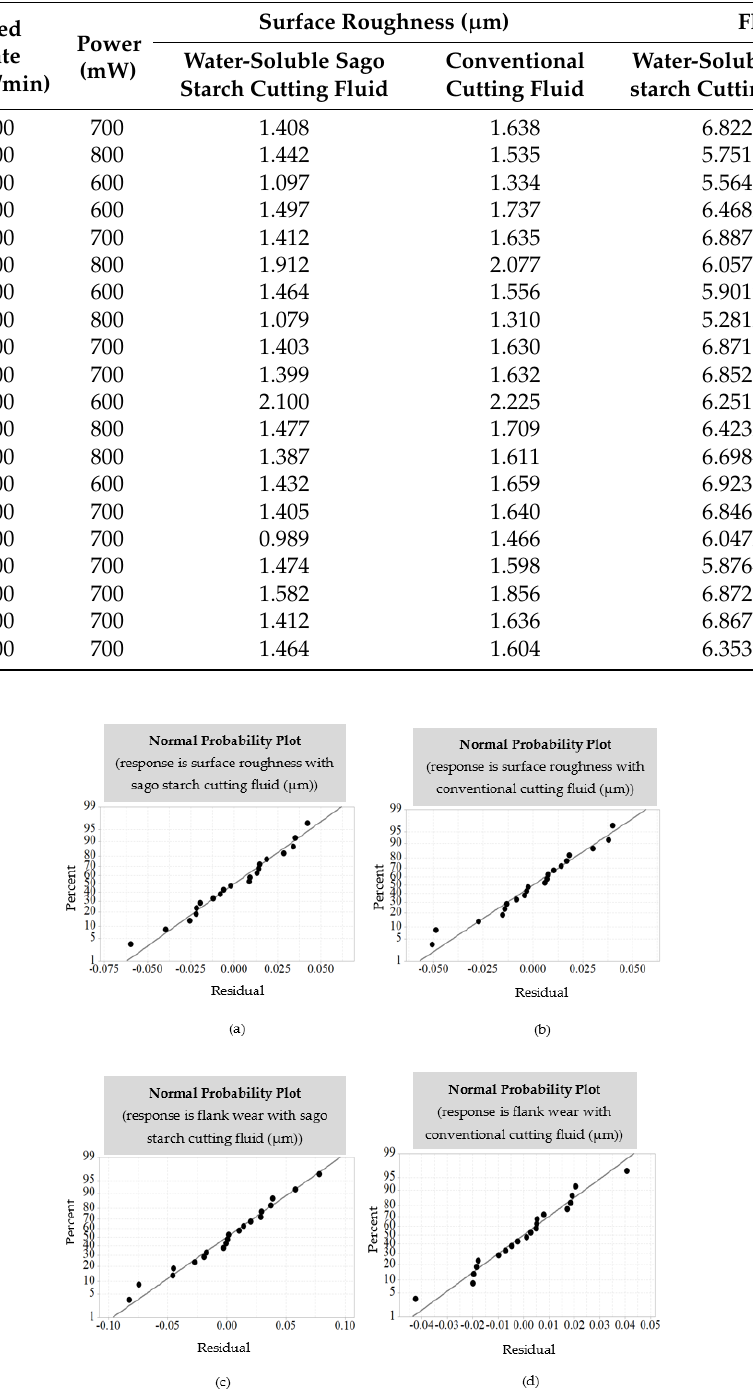
Table 7. Design of experiment and responses.